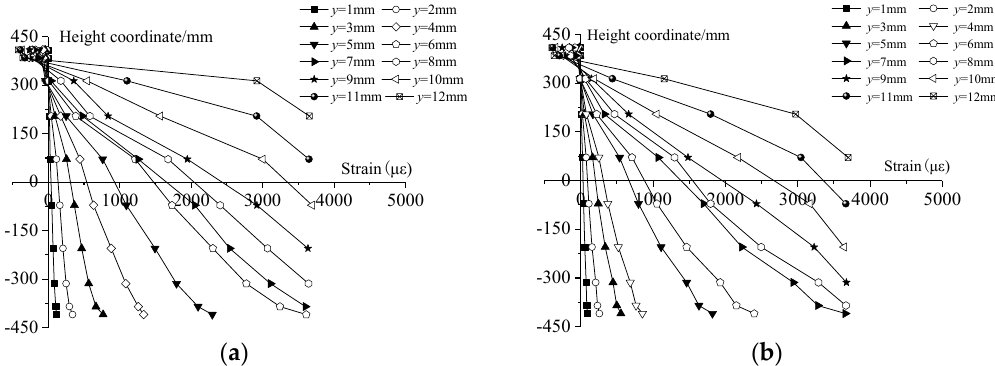
Figure 14. The strain measurements at each loading step in the areas influenced by a joint. ( a ) E10; ( b ) E8. Table 14. The values of χ , γ , and R 2 from the linear best-fitting equation for each loading step. Element